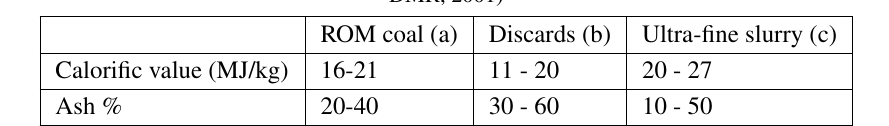
Table 1. Table 1.Typical characteristics of ROM coal, coal discards andultra-fine slurry (Source: (a) Coaltech, 2011; (b) &